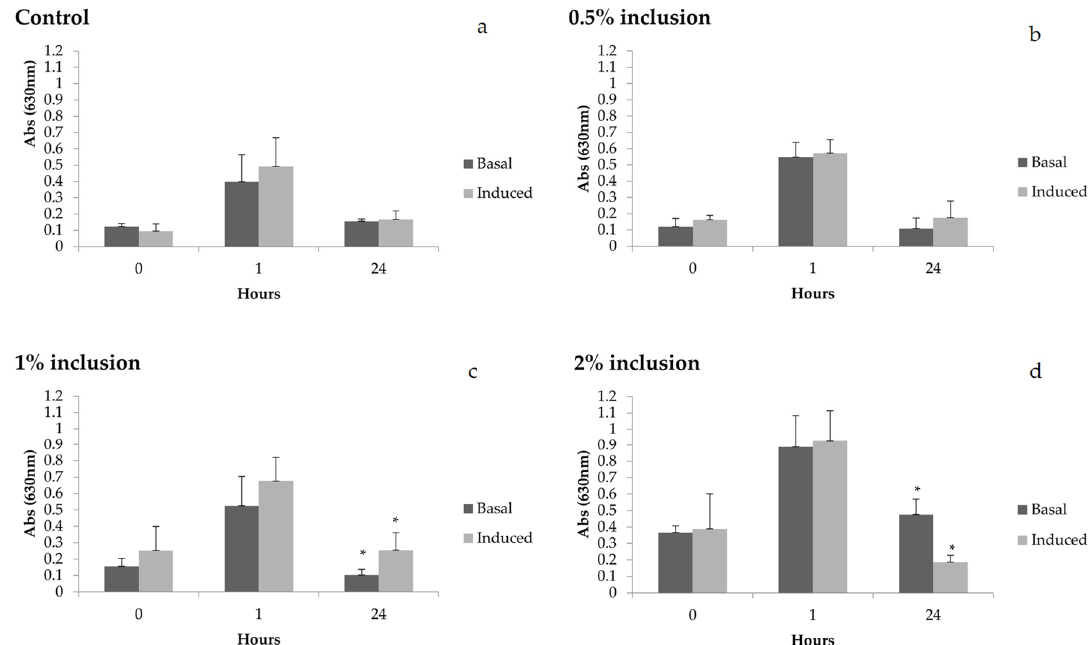
Figure 3. Reactive oxygen species (ROS) in basal and induced (laminarin) conditions before thermal shock (0 h) and after thermal shock (1 and 24 h) in Litopenaeus vannamei fed diets containing 0 ( a ), 0.5 ( b ), 1 ( c ) and 2% ( d ) of Nannochloropsis sp inclusion for 15 days. Scale bar represents average standard deviation (n = 4). Hours with * indicate statistical difference between basal and induction conditions. * Statistical difference found in the production of superoxide anions between basal and induced levels, in the treatment with 1% inclusion of the microalgae, in collection 24 h after the thermal shock ( p = 0.03639), and in collection 24 h after the thermal shock in the treatment with 2% inclusion ( p = 0.00138).